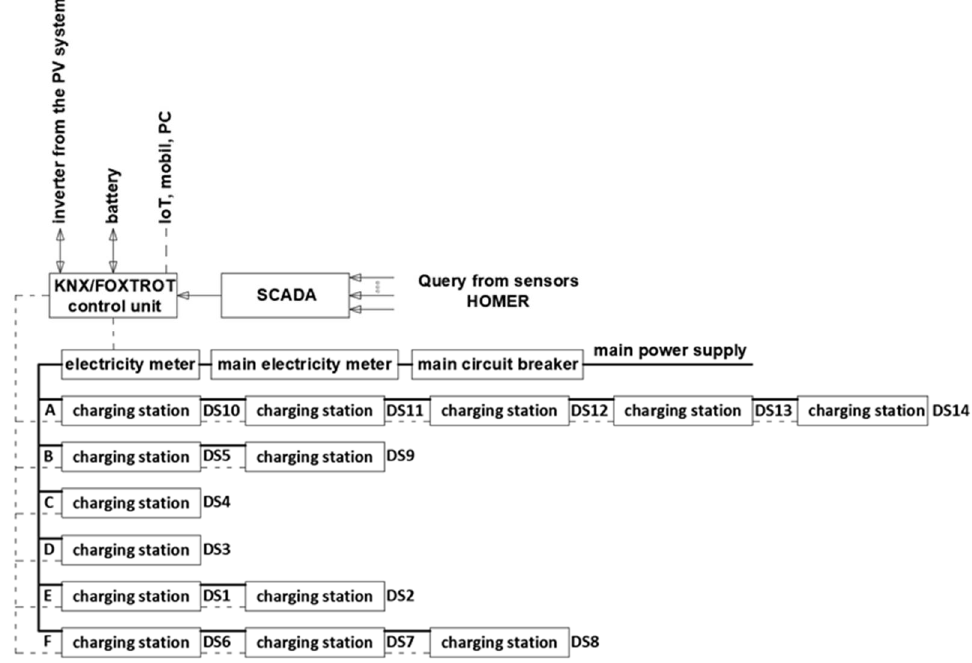
Figure 24. Simplified charging control scheme.